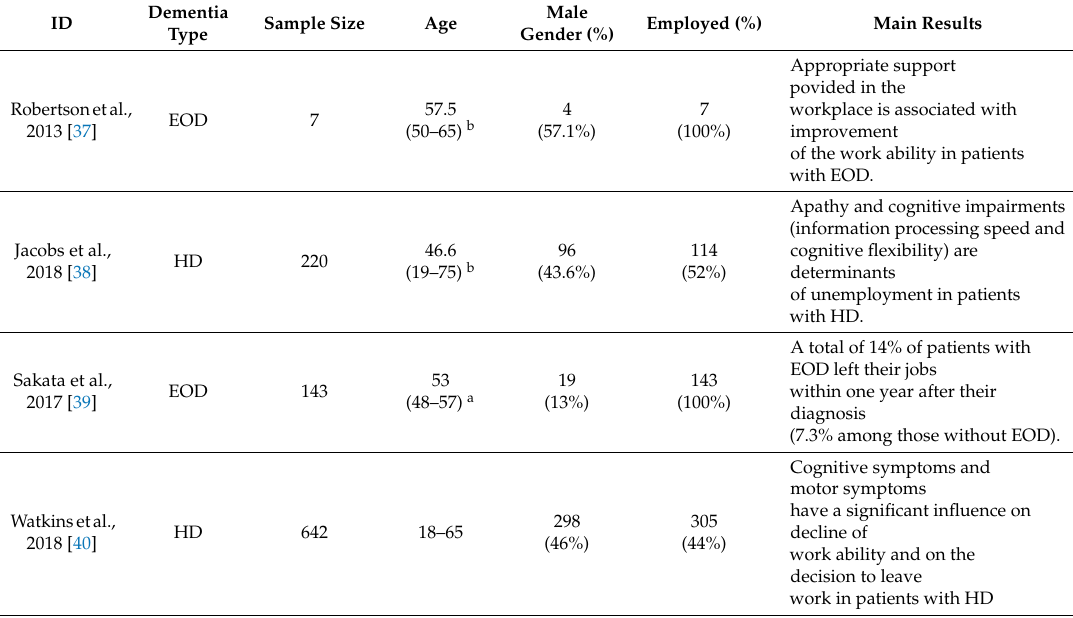
Table 1. Main characteristics and main outcomes of the included